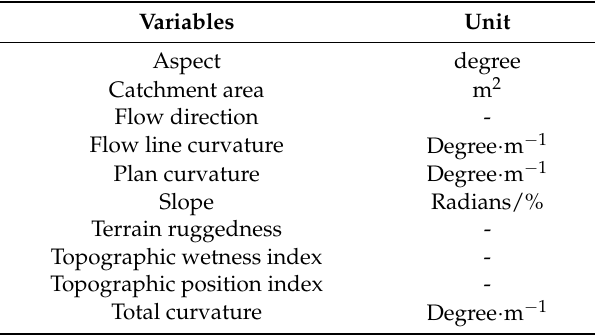
Table 2. Terrain attributes used as predictors for carbon